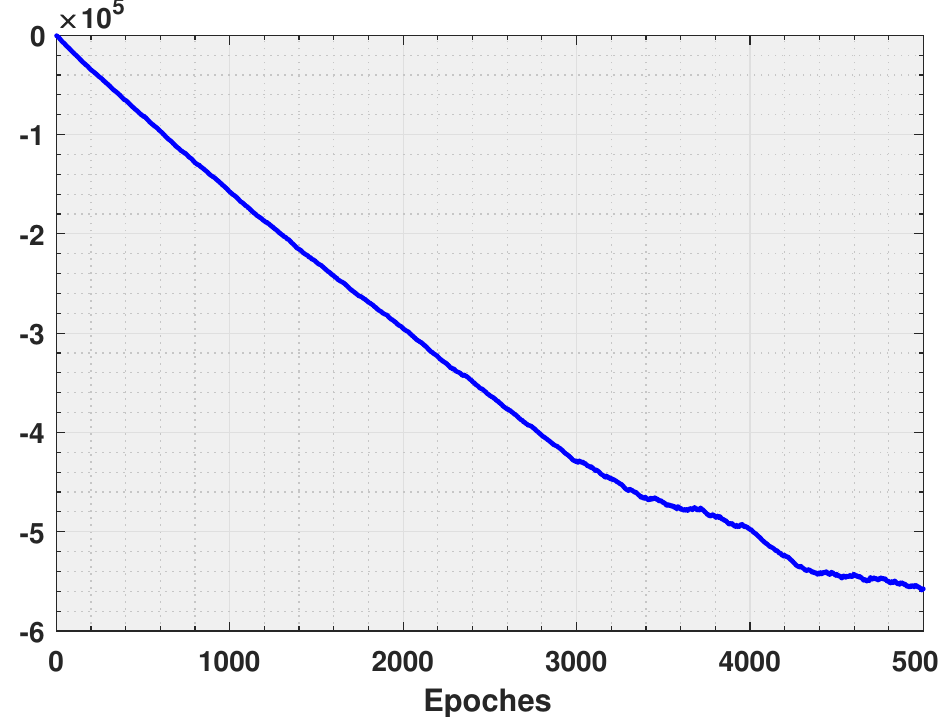
Figure 16. Reward accumulated throughout the training for the intelligent decision-making model